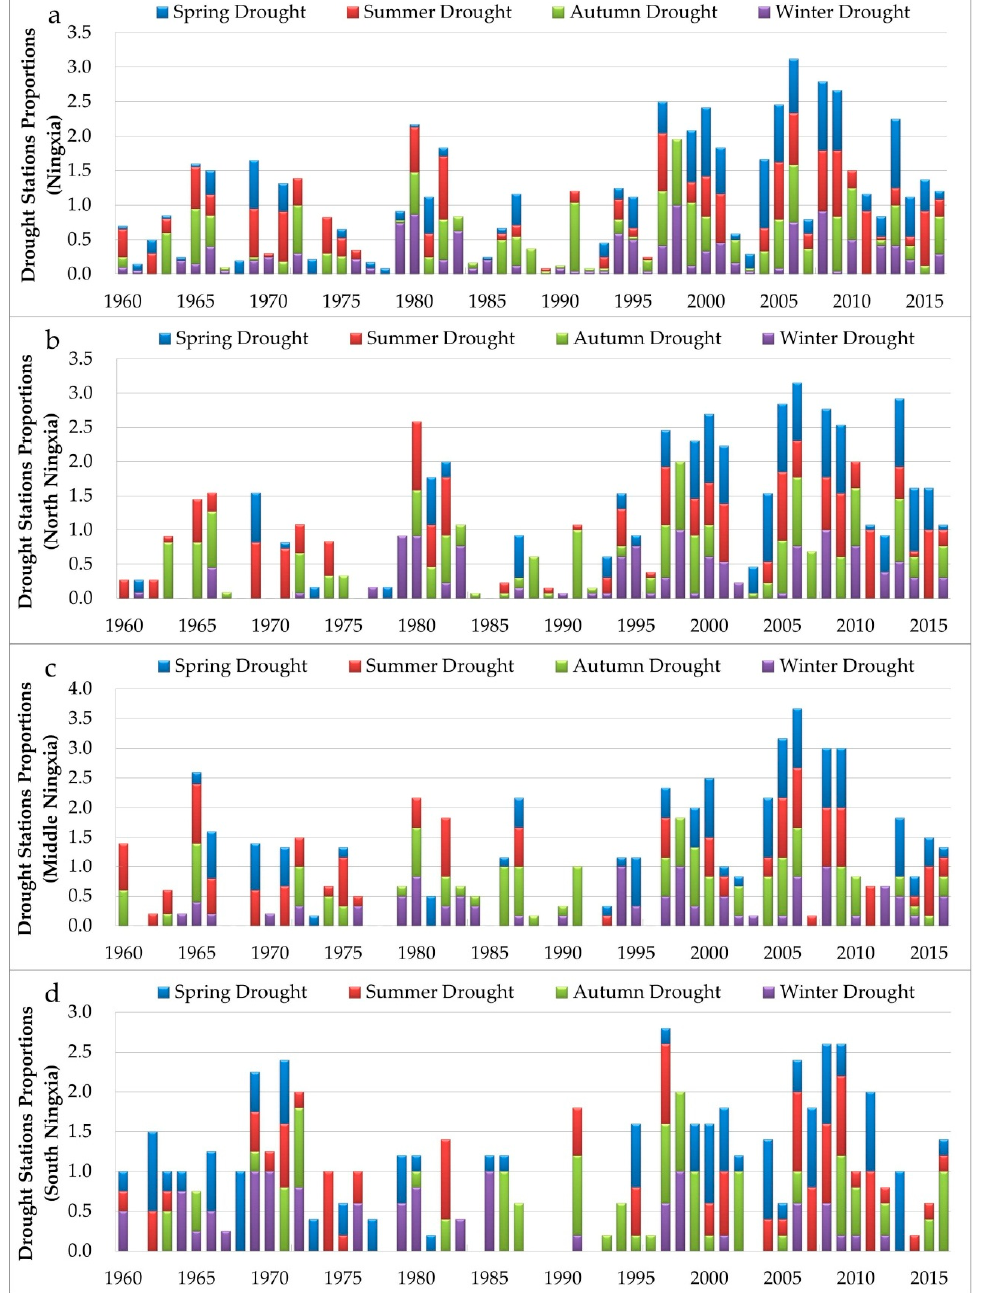
Figure 5. Cumulative drought stations’ proportions variation in Ningxia from 1960 to 2016. ( a ) Drought stations proportions in the whole region of each season; ( b ) drought stations proportions in the north Ningxia of each season; ( c ) drought stations proportions in middle Ningxia of each season; and ( d ) drought stations proportions in south Ningxia of each season.